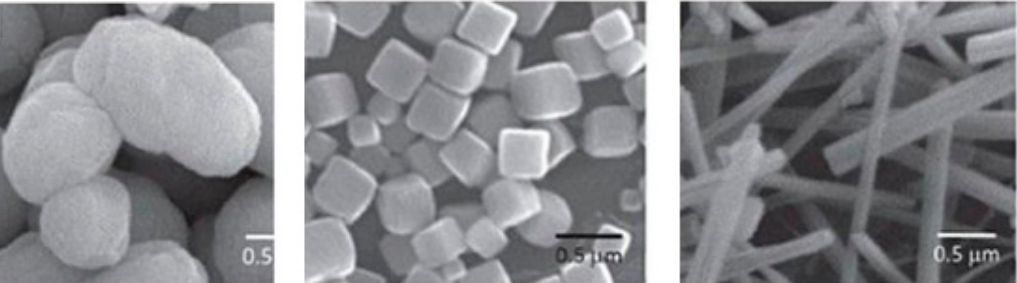
Figure 13. Co-precipitated perovskites with various crystal structures: ( left ) orthorhombic LaFeO 3 , ( center ) (Cubic SrTiO 3 ), and ( right ) hexagonal LaAlO 3 , and (Adapted from [60]).